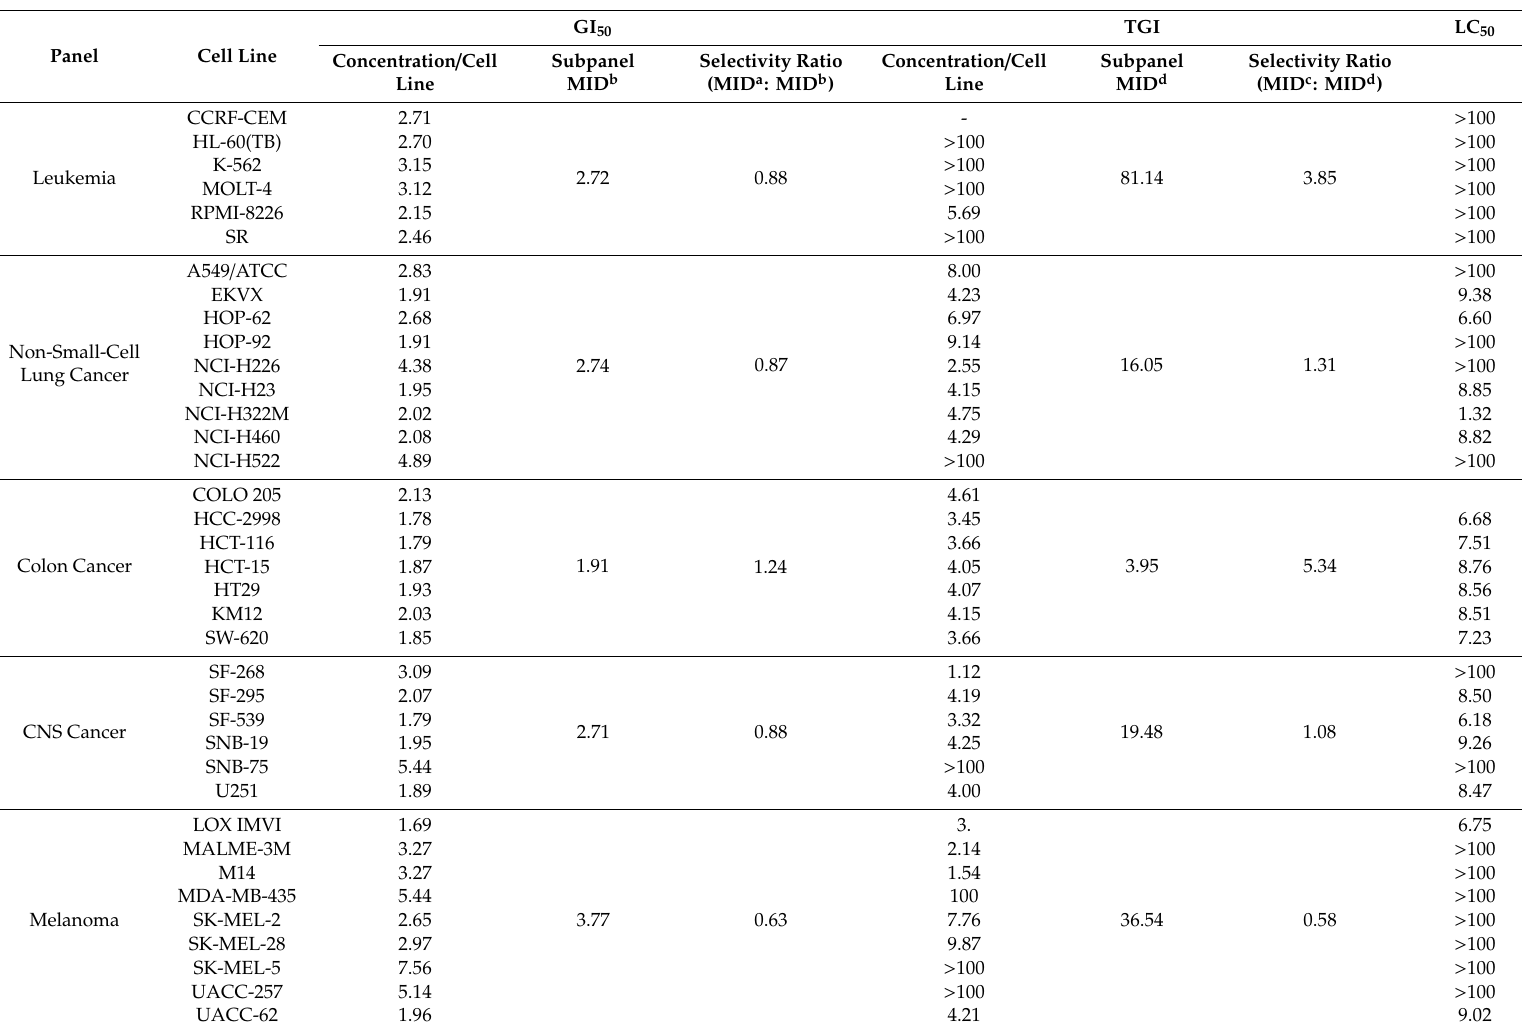
Table 2. Results of five in vitro doses (concentrations 0.01, 0.1, 1, 10, and 100 µ M) tested with nine human cancer types and selectivity for compound 3a.